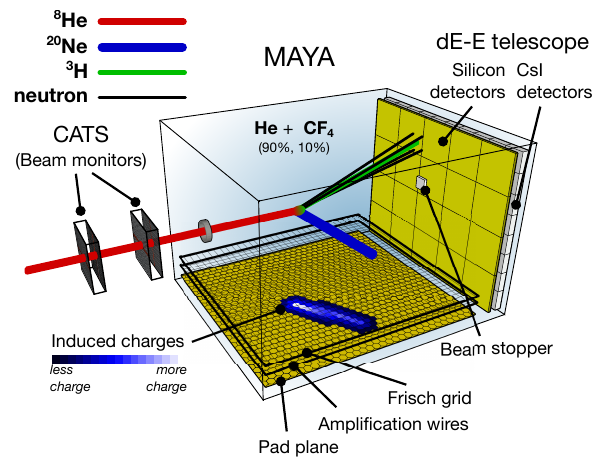
Figure 2. The 7 H resonance was produced and measured within the MAYA active target. A 8 He beam projectile is tracked and monitored with the CATS detectors before entering MAYA and colliding with a 19 F atom contained in the He + CF 4 filling gas, producing a 20 Ne nucleus and a 7 H resonance that decays into a 3 H nucleus and four neutrons. The 3 H nucleus is stopped and identified in the dE–E telescope, while the trajectory of the 20 Ne nucleus is projected onto the segmented pad plane and